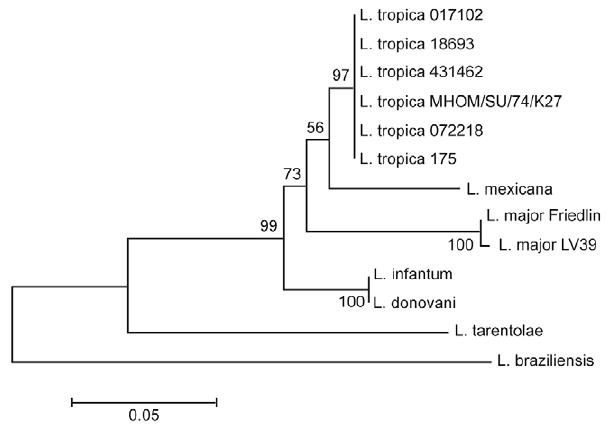
Figure 2. Phylogenetic analysis of the PTR1 sequences. Amino acid sequences were aligned using the ClustalW algorithm. The resulting multiple alignment was subjected to phylogenetic analysis by using the neighbor-joining method with Poisson correction as implemented in the MEGA3.1 software. The field isolates 017102, 431462, 072218, and 18693 from Afghanistan are clustering with the L. tropica reference strains 175 and MHOM/SU/74/K27. The reliabilities of each branch point were assessed by the analysis of 1000 bootstrap replicates.